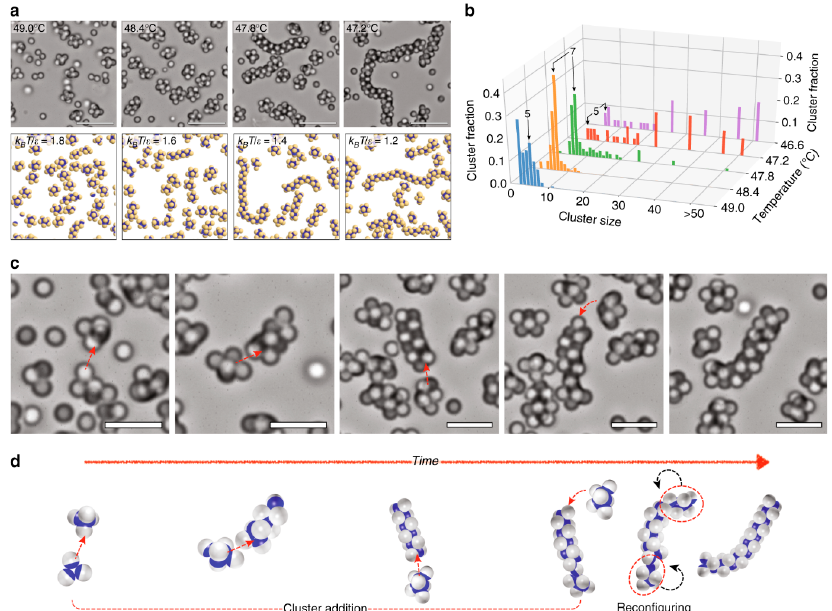
Figure 7. Self-assembly of Janus particles into clusters and chains at a patch ratio of 0.3. ( a ) Bright-field images above and simulation plots below show self-assembled structures of Janus particles at different temperatures; ( b ) Proportion in clusters of different sizes as a function of temperature. For cluster sizes greater than 20, histogram bars integrate over ten or more bins: 21–30, 31–40, 41–50, and >50. ( c ) Snapshots and ( d ) Figures show the formation of chain structures by collective polymerization through cluster addition and reconfiguration. Red arrow represents the formation of chain structure. Reproduced with permission from Oh et al. (2019), ©Nature Communication, 2019 [63].